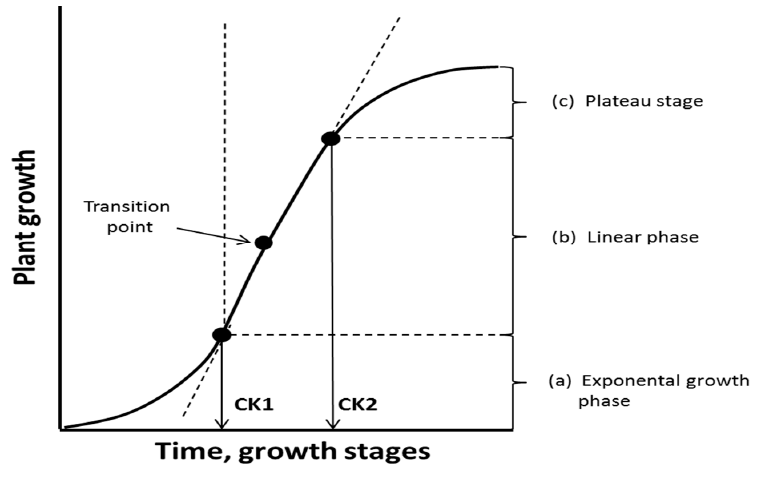
Figure 5. A conceptual pattern of dry matter accumulation by a typical seed/grain crop. Legend: CK1, CK2—cardinal stage 1 and 2, respectively (author’s own concept).